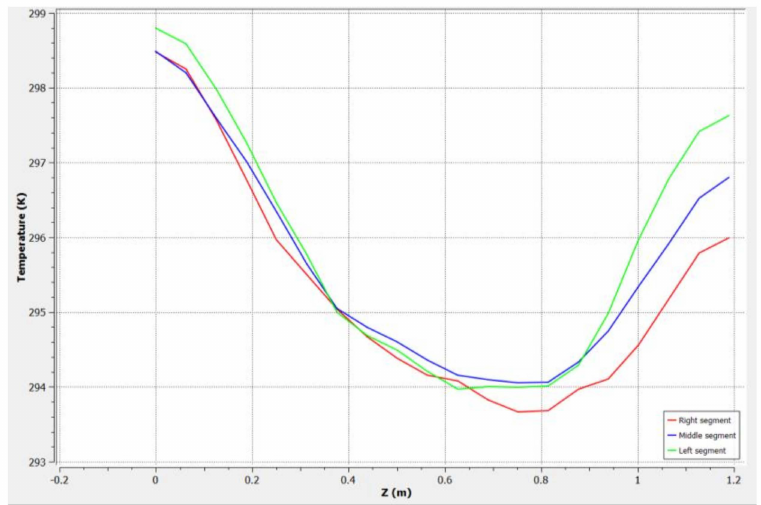
Figure 11. Temperature distribution of the cooling panel for Design 1.